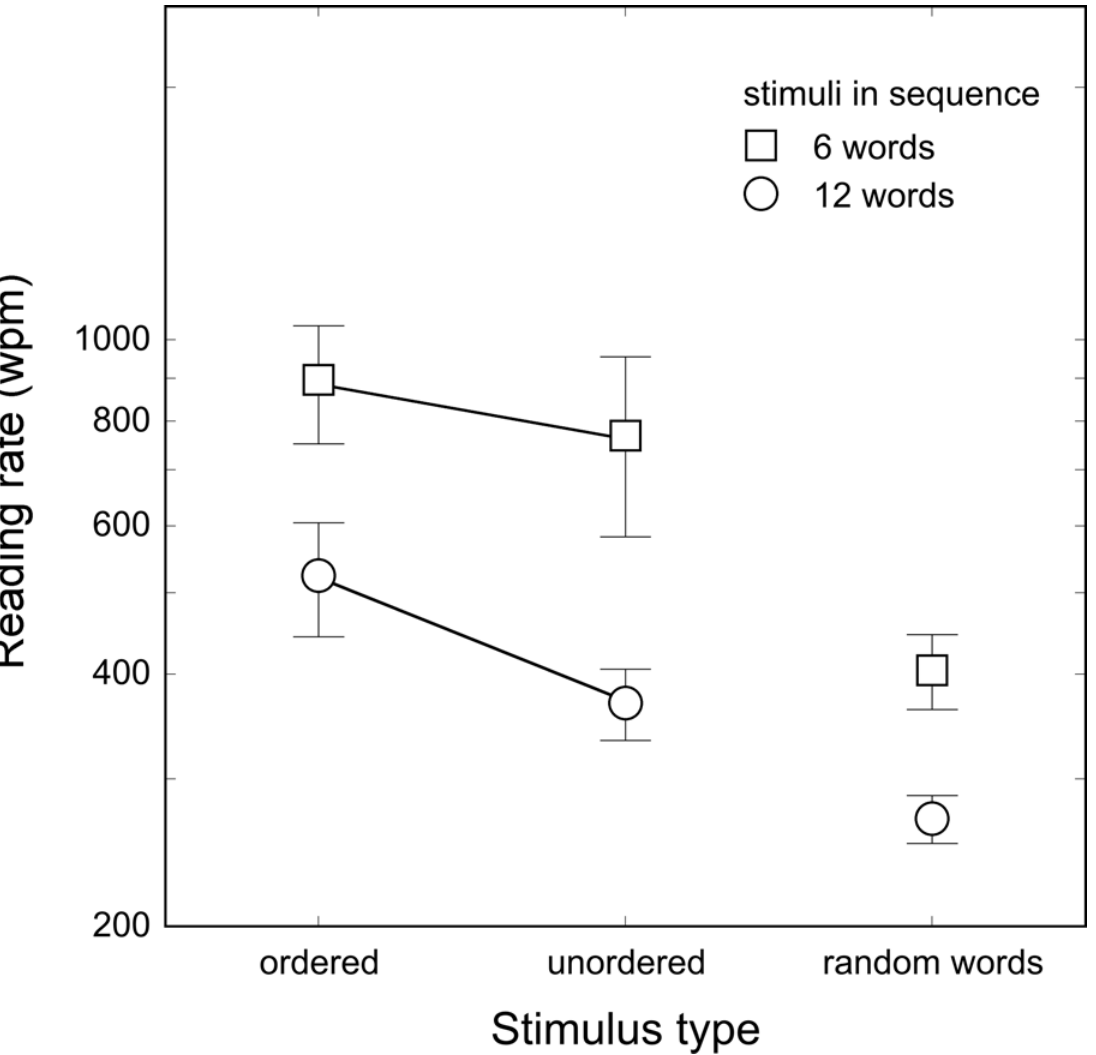
Fig 6. Reading rate (in wpm) for ordered and scrambled text and random (5-letter) words. Two conditions were given: 6-word sequence (black squares) and 12-word sequence (white squares). Bars represent standard